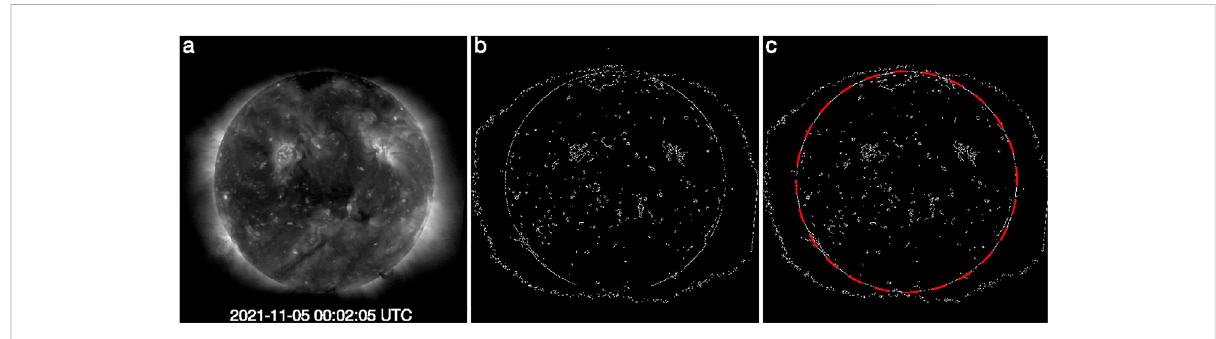
FIGURE 2 Tested solar image sample. (A) is the original image, (B) is CANNY edge detection, and the red curve in (C) is the optimal circle in the CANNY edge graph.